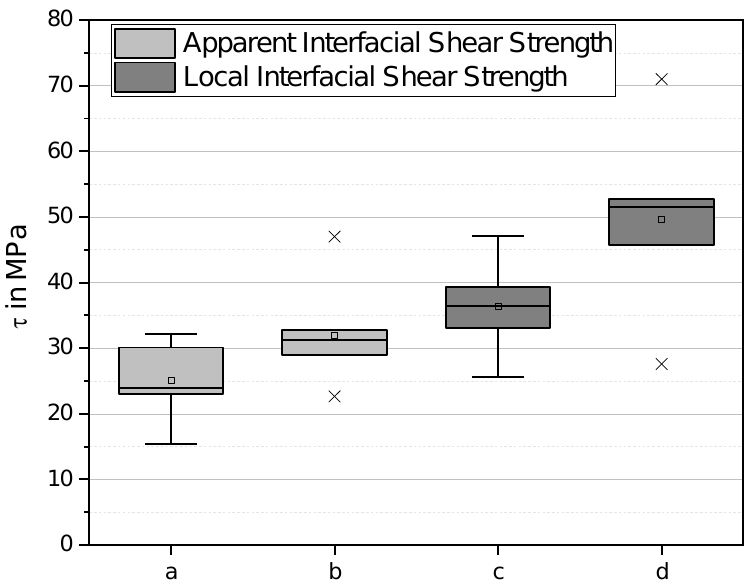
Figure 8. (a,b) Apparent interfacial shear strength (IFSS) ( τ app ) and (c,d) local IFSS ( τ d ), 7 evaluable samples each, modification with buffer only (a,c) and buffer + laccase + dopamine (b,d). Results are presented in a boxplot format, the horizontal line mark the median, the hollow dot marks the mean, boxes represent the centre quartiles, whiskers denote 1.5 times the interquartile range, × marks outliers.